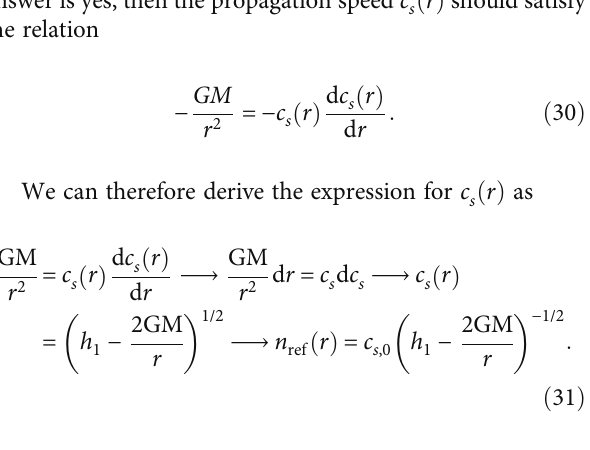
Figure 1: This fi gure shows the relation between refractive index and radial distance to the centre of SCO 1: n = 1 , h = 1 , GM = 1/2 With c 1 s ,0